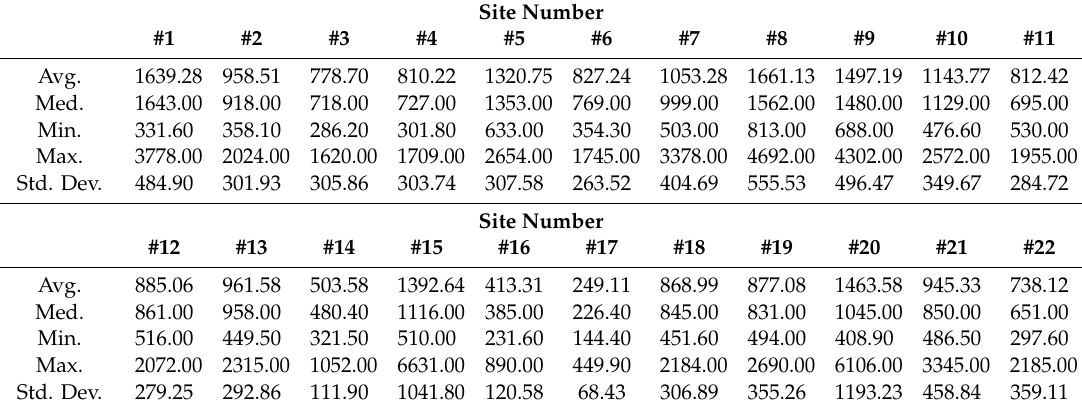
Table A4. Descriptive statistics of water specific conductance ( µ S / cm) at each sampling location (n = 22) during study period (2 January 2018–1 January 2019) in West Run Watershed, WV, USA. Avg. = average, Med = median, Min. = minimum, Max. = maximum and Std. Dev. = standard deviation.